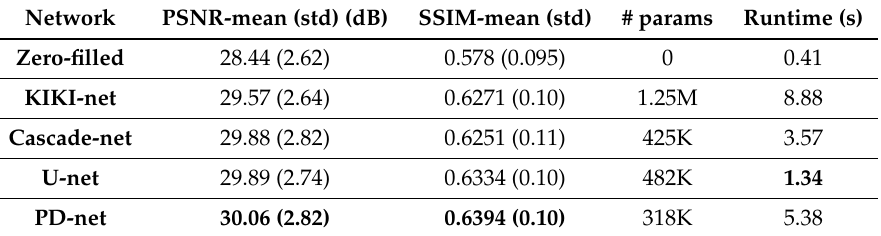
Table 2. Quantitative results for the fastMRI dataset with the Proton density fat suppression (PDFS) contrast. PSNR and SSIM mean and standard deviations are computed over the 99 validation volumes. Runtimes are given for the reconstruction of a volume with 35 slices.